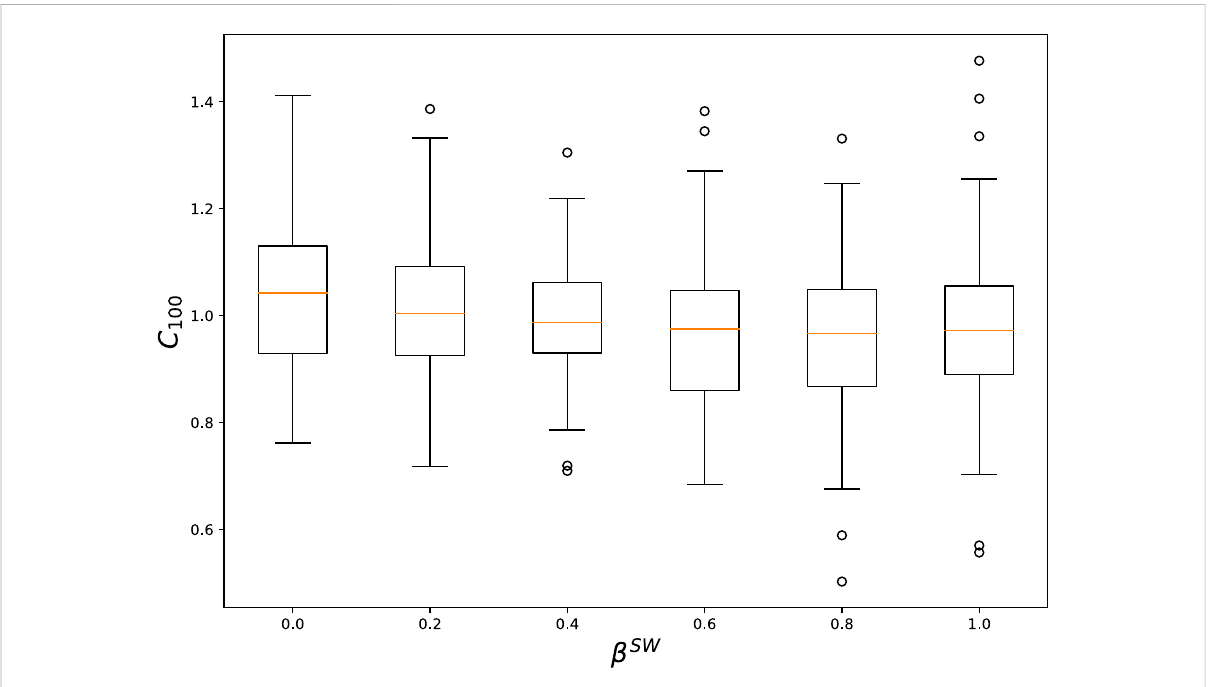
FIGURE 4 Boxplots of the degree of convergence, C 100 for different values of β SW . Each boxplot represents 100 trials with different random seeds. Here, the parameters were (| N |, α , β , κ , θ , δ ) = (400, 1, 10, 5, 0.86, 0.04). For thedifference between the population means with β SW = 0 and β SW = 1,the level of signi fi cance from Student ’ s t-test was 0.001243, indicating 1% signi fi